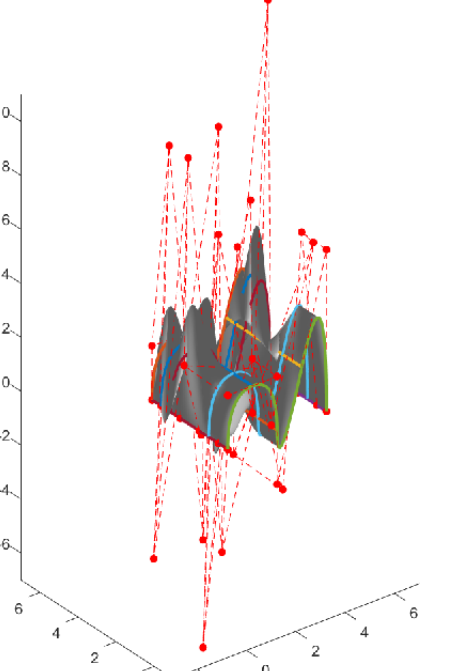
Figure 6. ( a ) Tensor product and ( b ) triangulated surfaces with U = 0,0,0,1,2,3,4,5,5,5 and the two free control points C 1,1 = ( 1,1,1 ) and C 1,3 = ( 3,6,7 ) , V = { } interpolating the curve network in Figure 5.